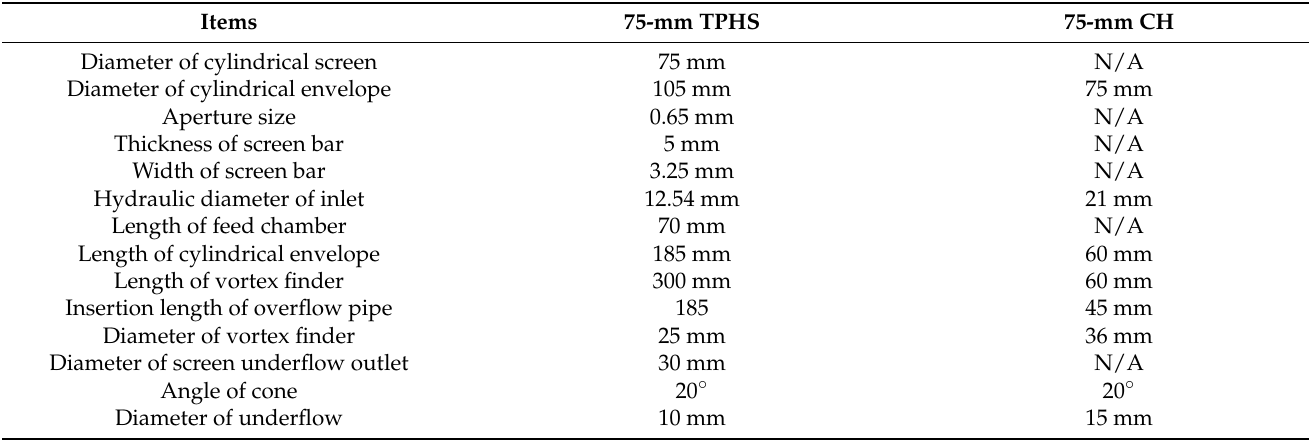
Table 1. Comparison between TPHS and CH in computational fluid dynamics (CFD) simulation.